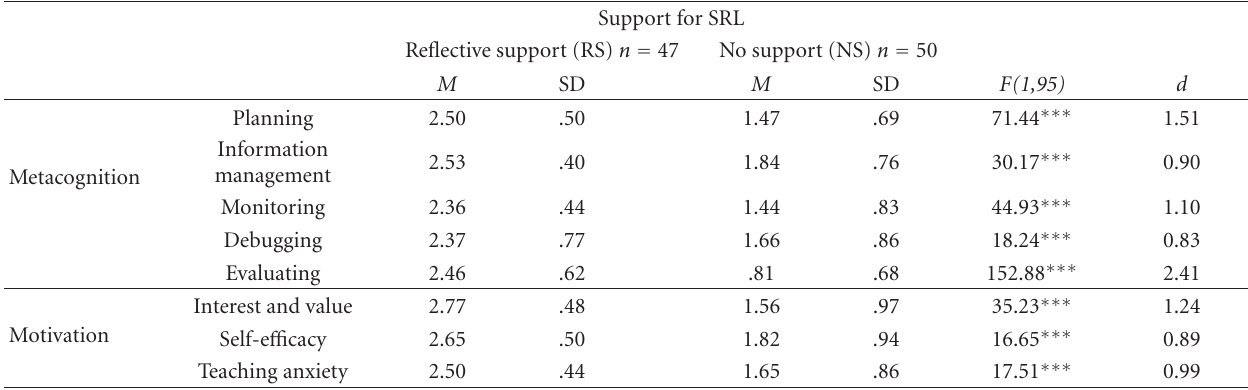
Table 2: Mean scores, standard deviations, and Cohen’s d scores for SRL (metacognition and motivation) by experimental